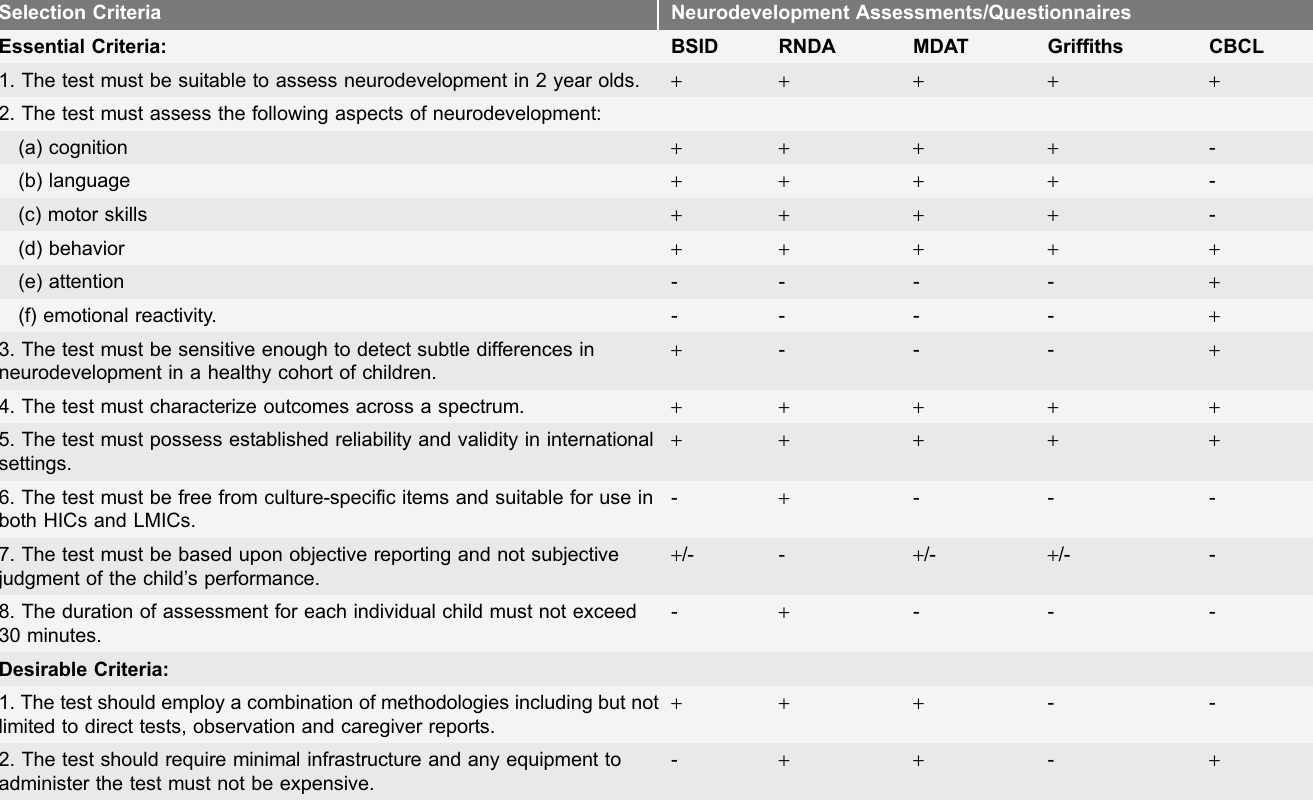
Table 8. Analysis of candidate cognitive, language, motor, behavior and attention tests against selection criteria. Selection